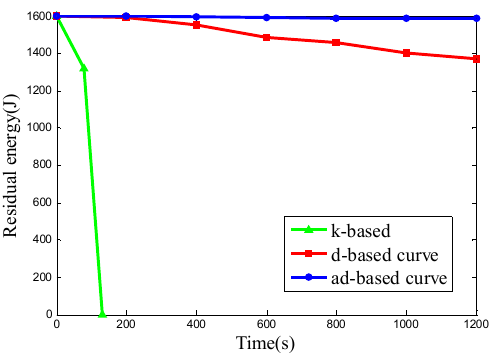
Figure 22. The residual energy of the network in node deployment (b): C 1 , C 3 are deployed with 50 nodes and C 2 , C 4 are deployed with 350 nodes.